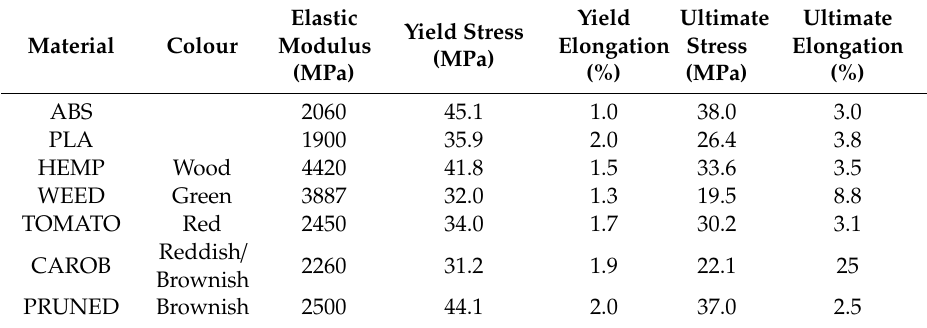
Table5. Main mechanical properties of new composites in comparison with acrilonitrile-butadiene-stirene (ABS) and pristine polylactic acid